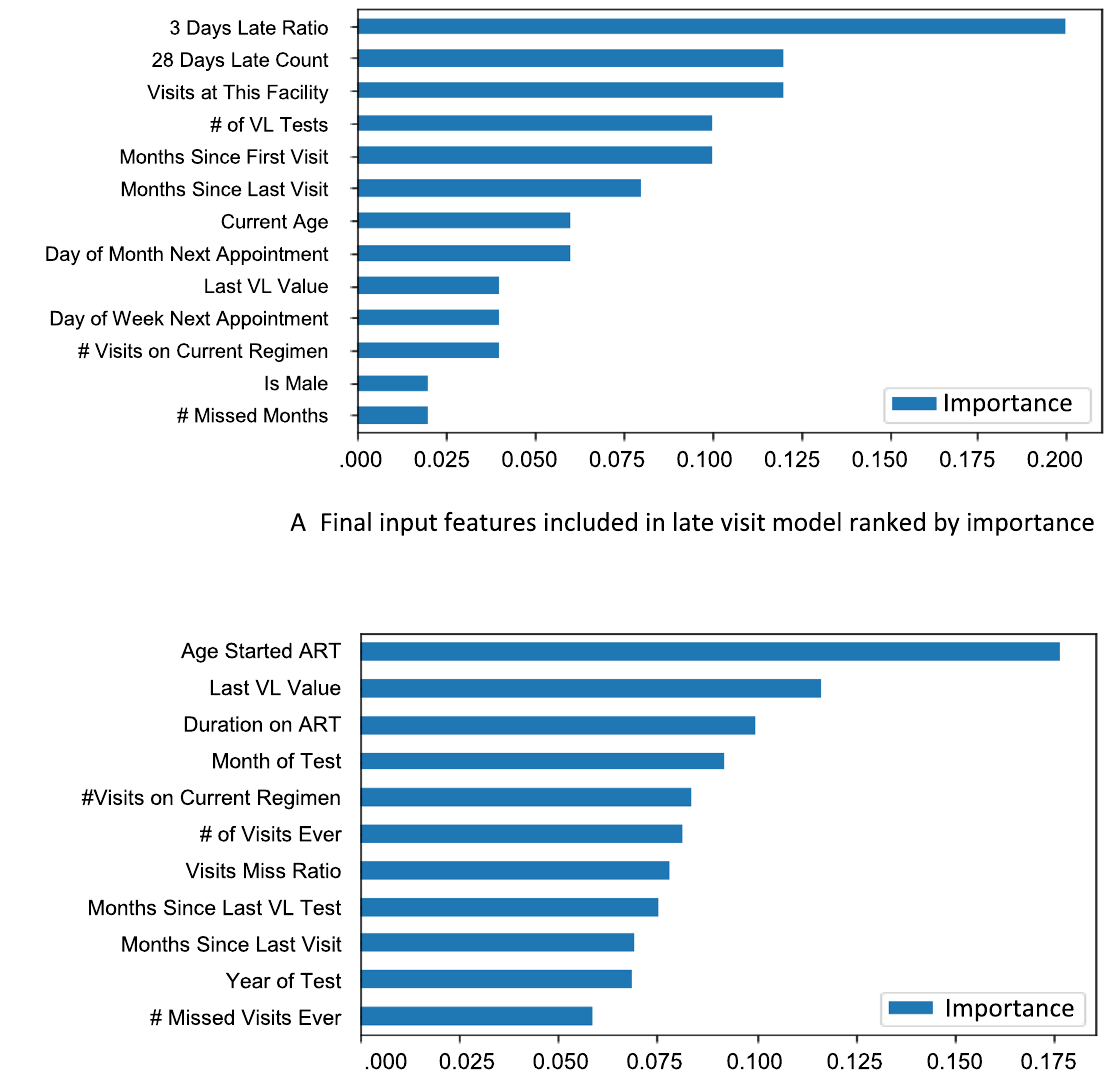
Figure 3. ( A ) Final input features included in late visit model ranked by importance. ( B ) Final input features included in unsuppressed VL model ranked by